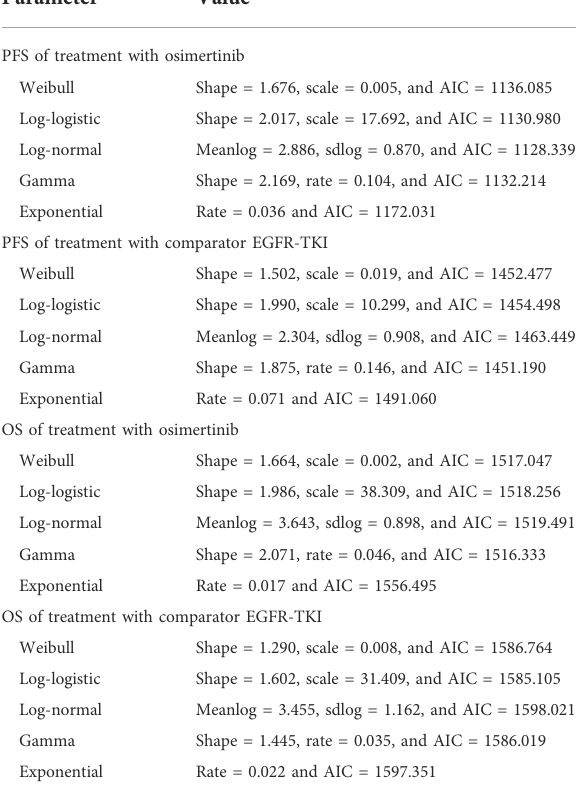
TABLE 1 Relevant parameters of different survival